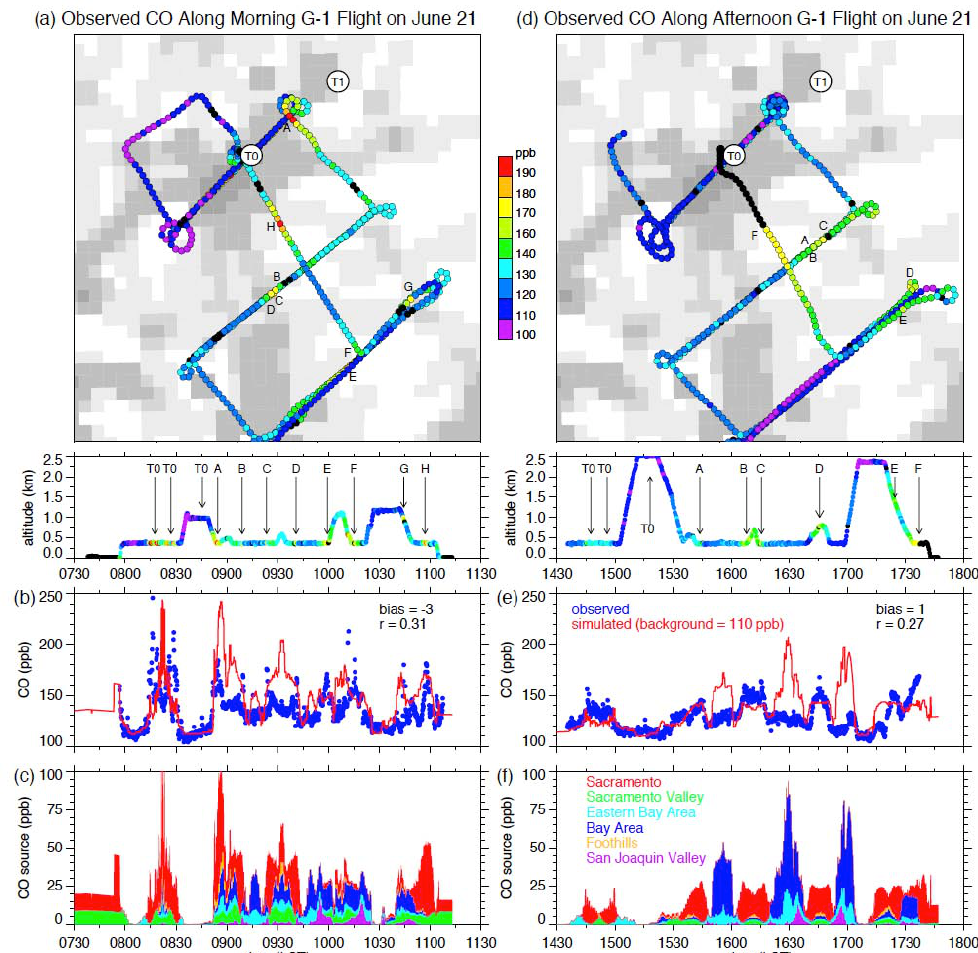
Fig. 12. Same as Fig. 11, except for 21